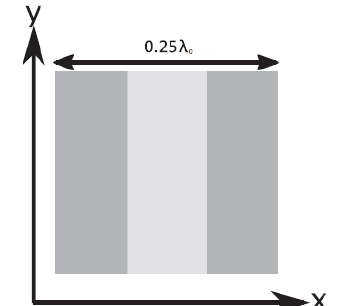
Figure 8: Inhomogeneous square problem Wavelength in homogeneous structures is constant every- where in the scatterer. However, an inhomogeneous structure